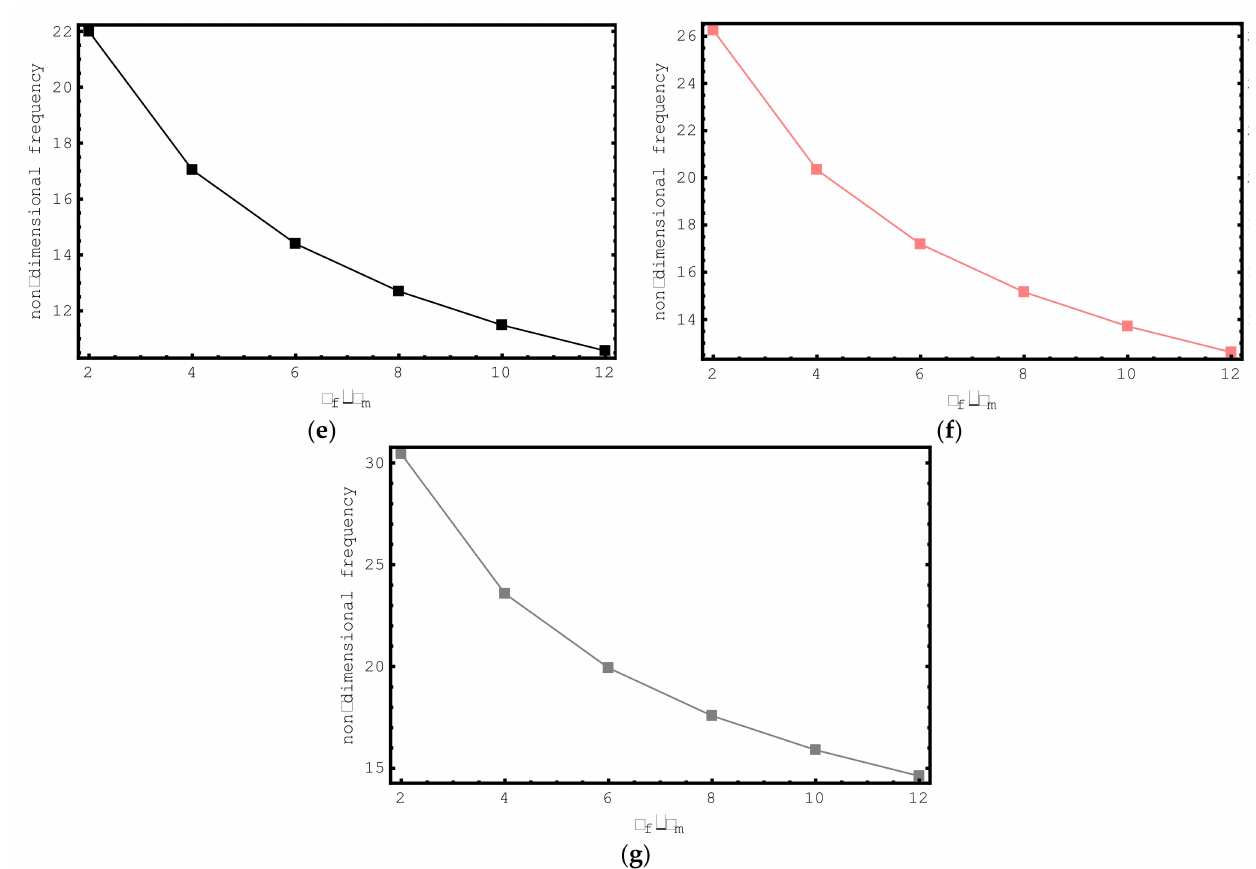
Figure 10. The variations of non-dimensional frequencies of short-fiber-reinforced composite nano- rods versus ρ f / ρ m : ( a ) 1st mode ( b ) 2nd mode ( c ) 3rd mode ( d ) 4th mode ( e ) 5th mode ( f ) 6th mode ( g ) 7th